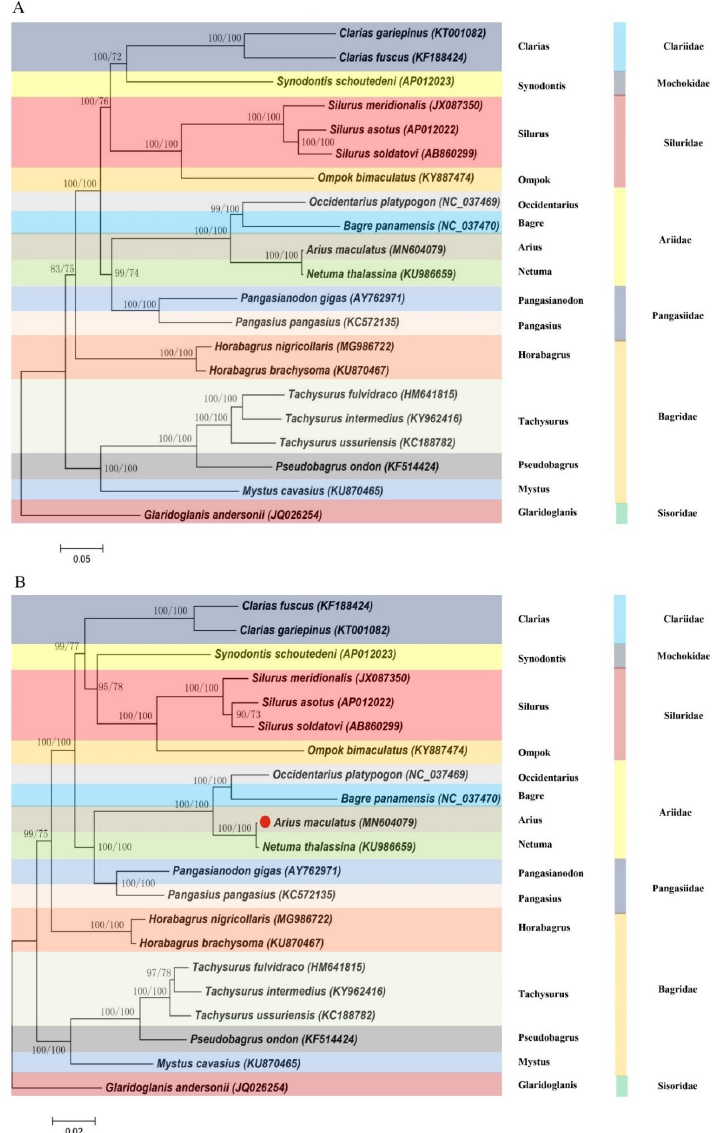
Figure 7. Phylogenetic trees of A. maculatus relationships from the ( A ) nucleotide and ( B ) amino acid datasets. Sequences alignments of mtDNA were analyzed using the RAxML and MrBayes software with the ML and BI method, respectively. Numbers at the nodes are bootstrap values (right) and Bayesian posterior probabilities (left). The accession numbers of the sequences used in the phyloge‑ netic analysis are listed in Table